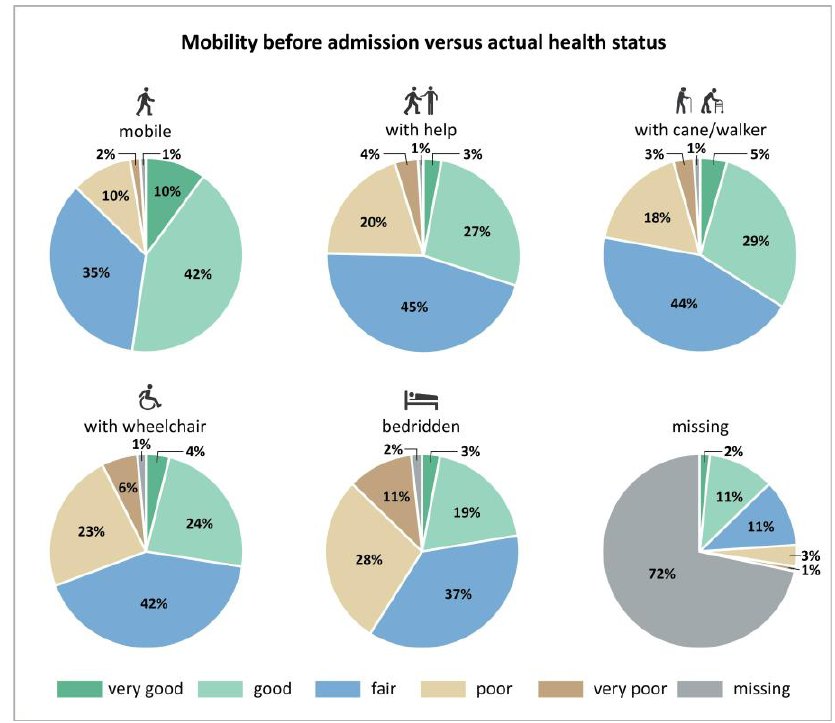
Figure 2. Mobility before hospital admission versus self-reported actual health status at nutritionDay ( n = 48,700).